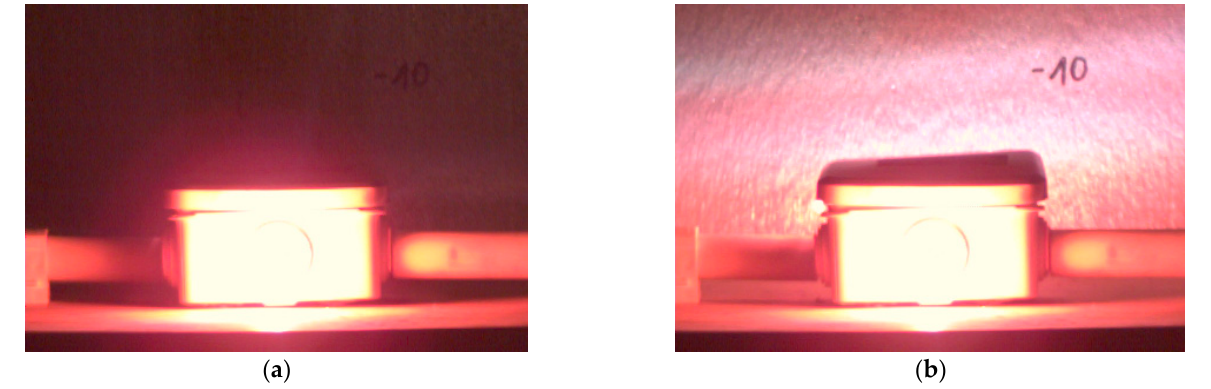
Figure 11. Subsequent frames from recording the behavior of the test object: ( a ) just before unsealing the electrical installation box, ( b ) immediately after opening the electrical installation box; 225 µs time interval.